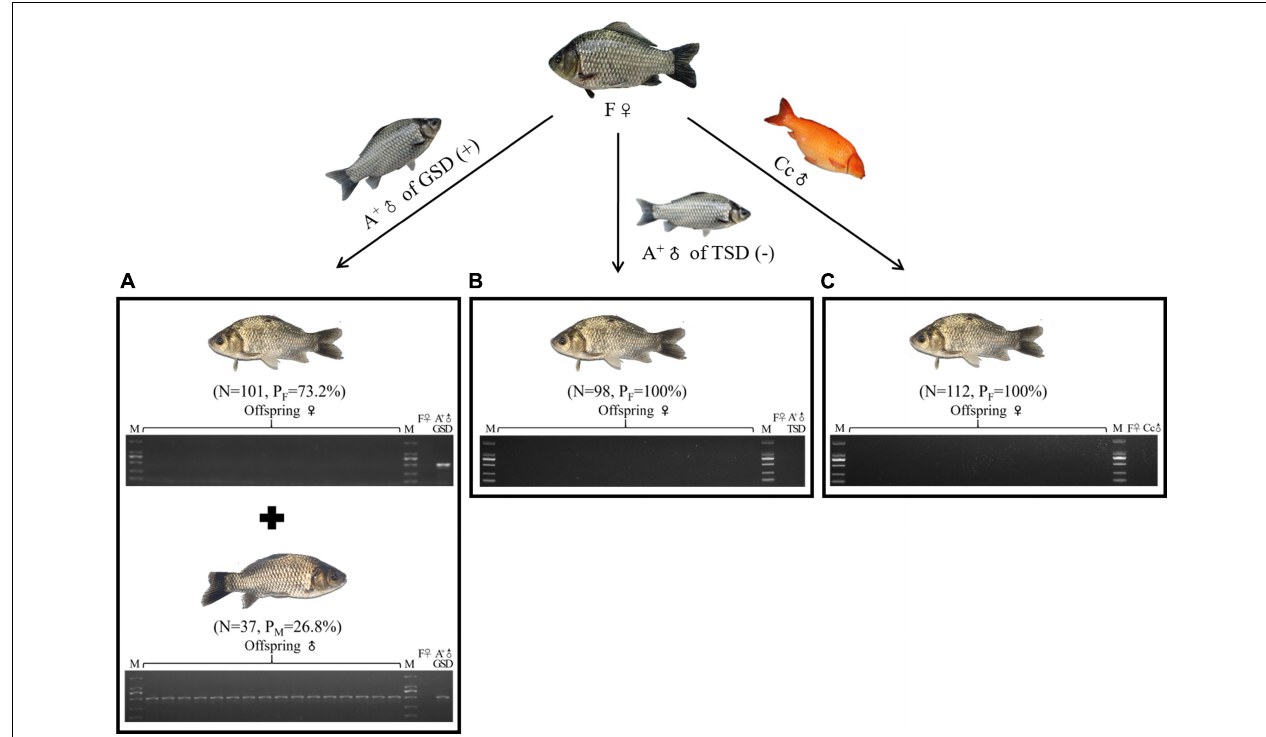
mating with A + of GSD (A) , A + of TSD (B) , and Cc (C) , respectively. , female; , male; (+), with GMM; (–), without ♀ ♂ ♂ ♂ ♀ ♂